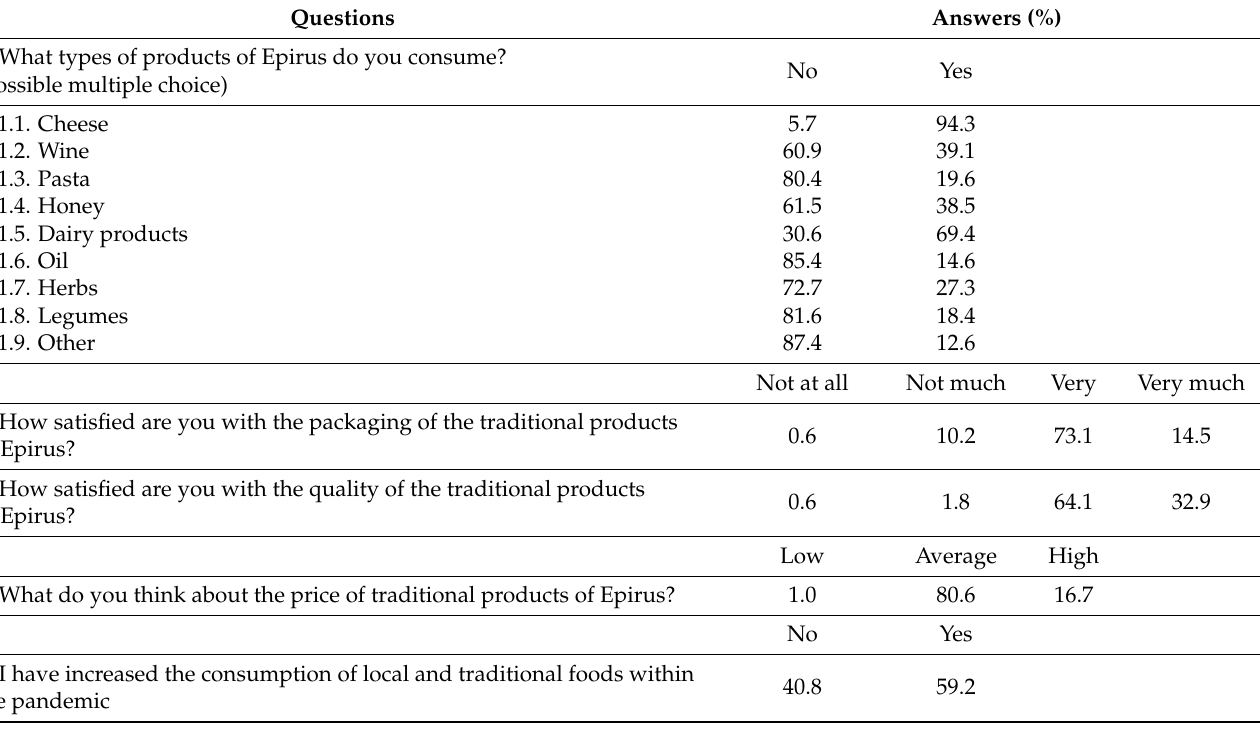
Table 8. Participant’s evaluation of Epirus’